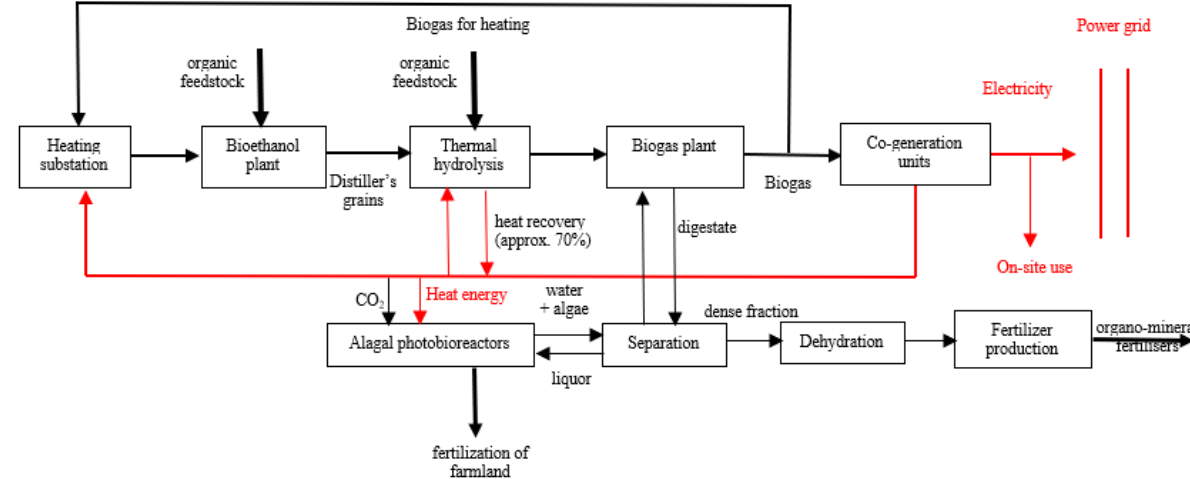
Figure 6. Biorefinery visualization. (1—bioethanol plant, 2—biogas plant, 3—microalgae photobioreactors, 4—feedstock silos, 5—office premises, monitoring and control systems).